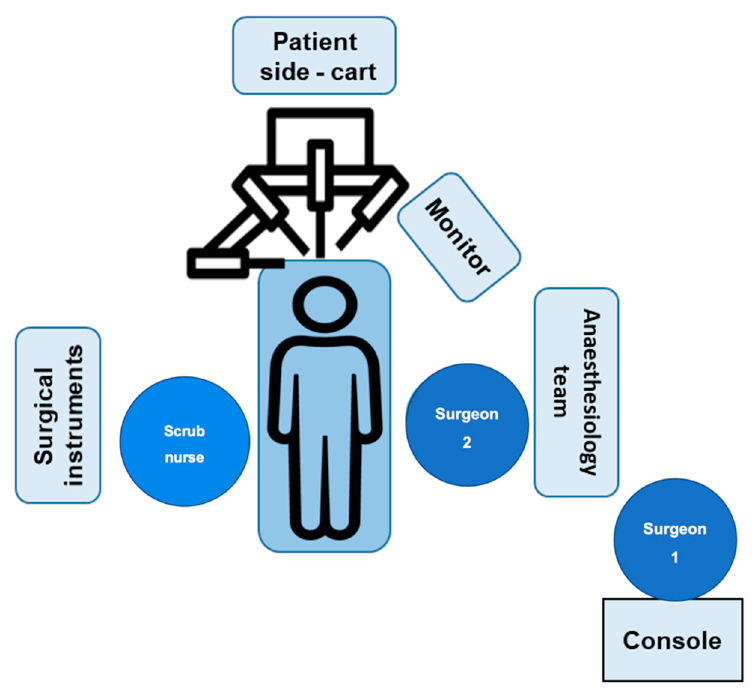
Figure 1. Setting description of the Da Vinci robotic system in the operating room. After the usual surgical preparations, the surgeon is seated at the da Vinci system console.